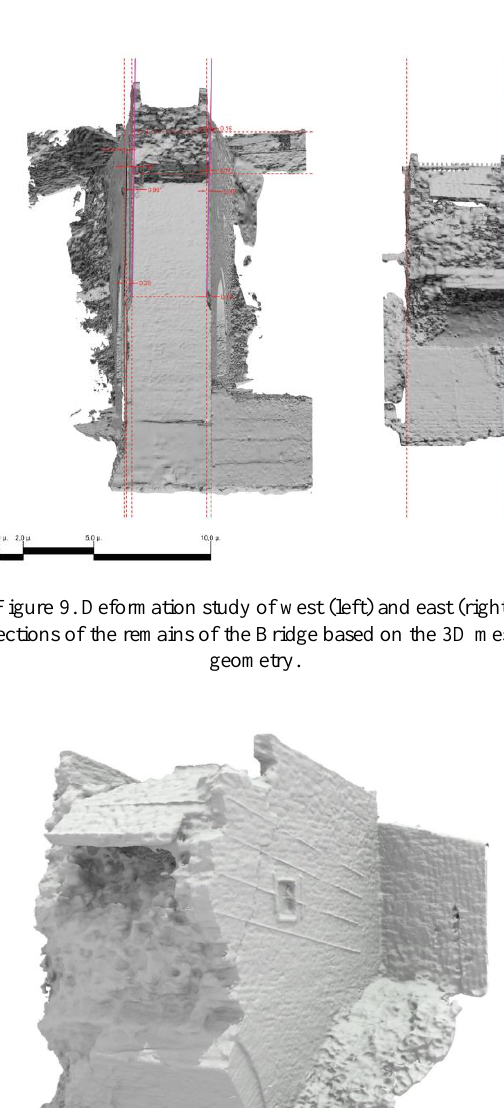
Figure 10. Untextured detail of the east pillar ruins: Larger and minor cracks are easily noticed, as well as grout depth and stone sizes and shapes